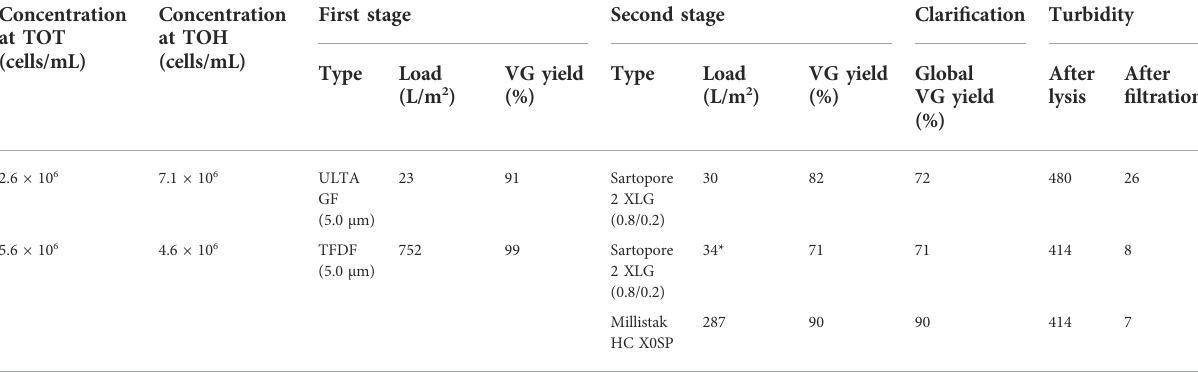
TABLE2Clari fi cationofbatchcultures.Atwo-stage fi ltrationprocesswasused;the fi ltersinthe fi rststagehavethesameporesize(5 µm);thesecond stage fi lters are depth fi lters. Concentration at TOT